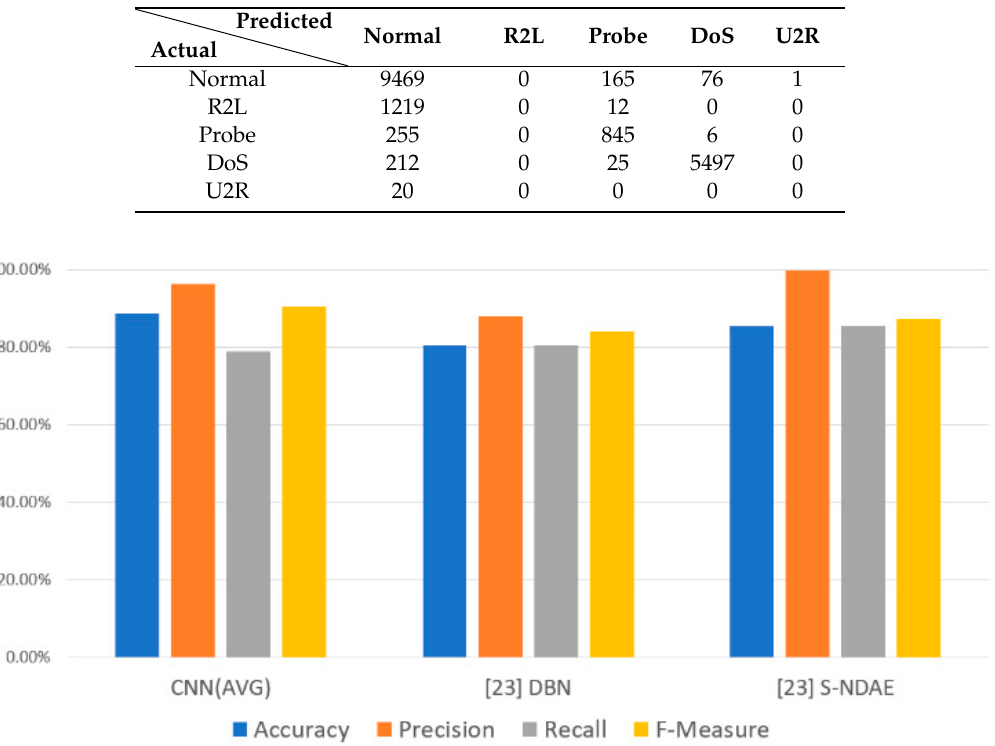
Figure 4. Performance comparison with modified NSL-KDD Test+.